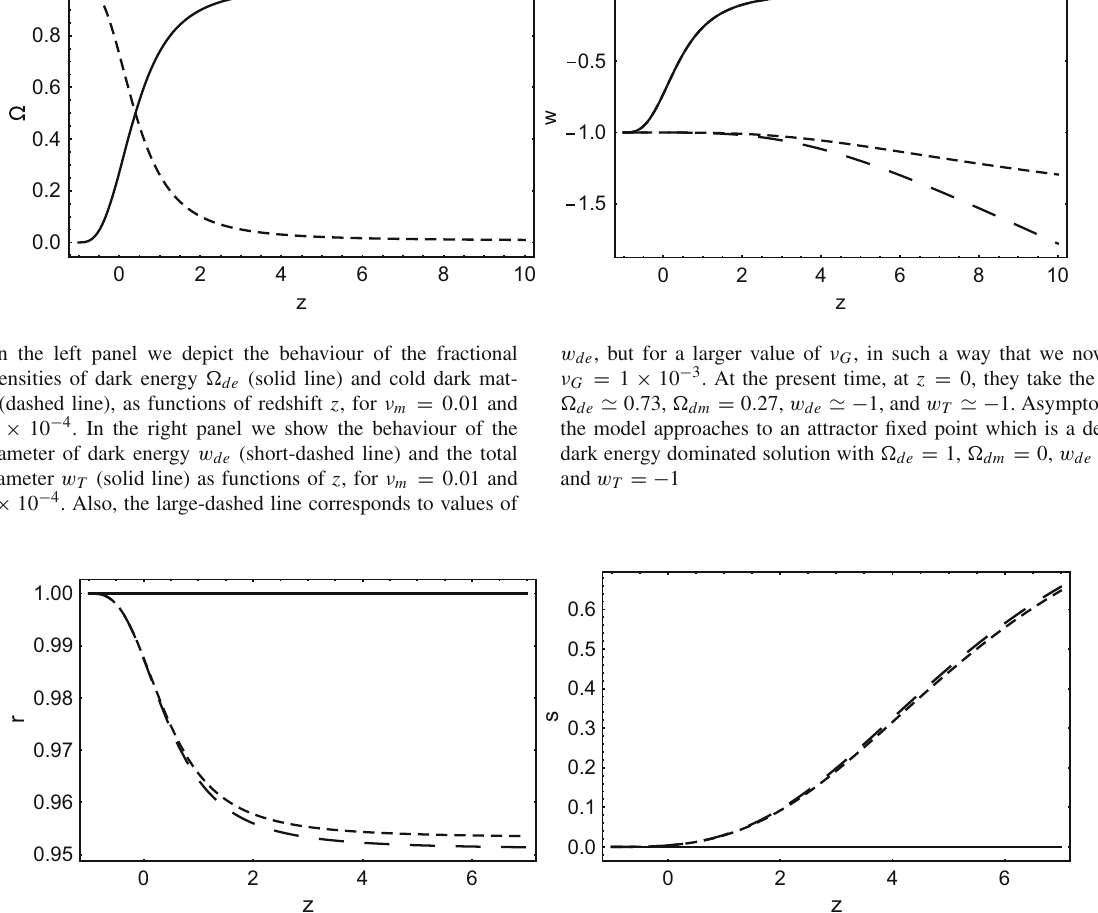
model. It is seen that asymptotically, when z → − 1, the system tends to a de Sitter solution, r = 1 and s = 0, consistently with previous results of dynamical systems